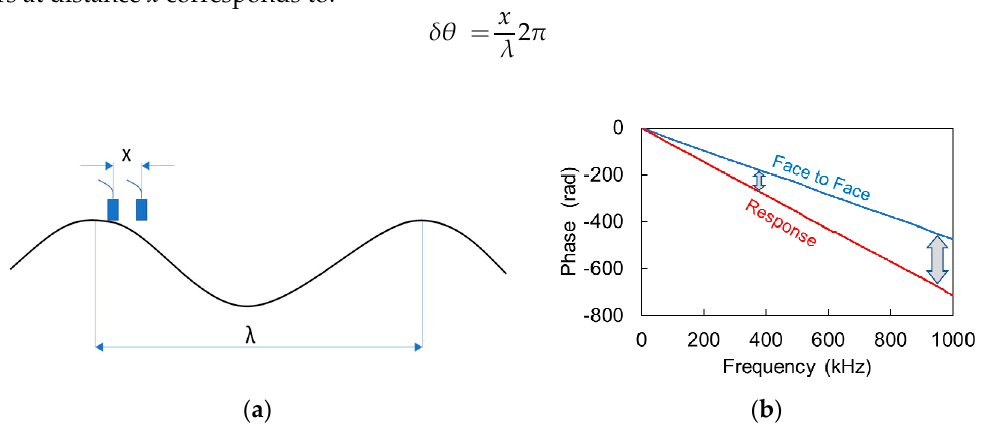
Figure 4. ( a ) Wavelength and sensor distance, ( b ) FFT phase of face-to-face signal and material (water) response. The arrows designate the increasing phase difference with frequency.